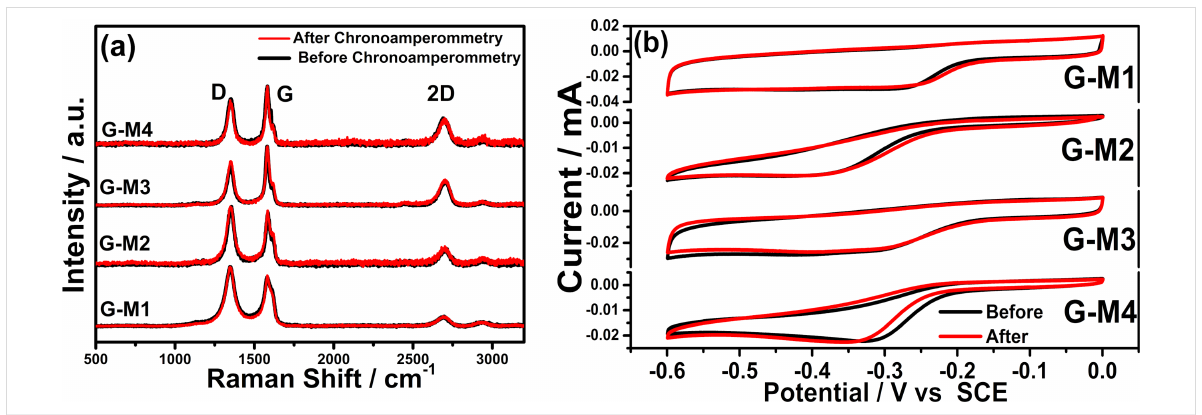
Figure 5: (a) Raman spectra of EEG samples before and after 3 h of chronoamperometry in 0.5 M H 2 SO 4 solution at 0.45 V vs RHE. (b) ORR in 0.1 M KOH solution before and after chronoamperometry.